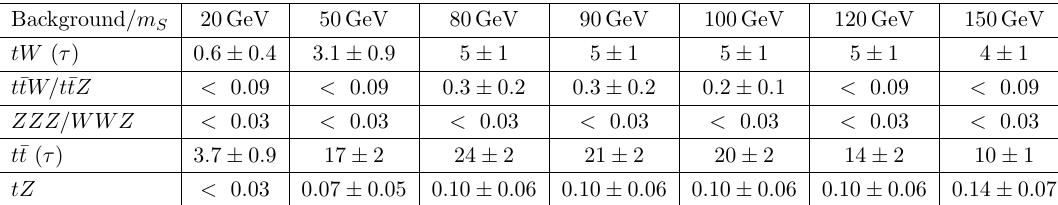
Table 8 . Event yields for the last selection cut on m rec